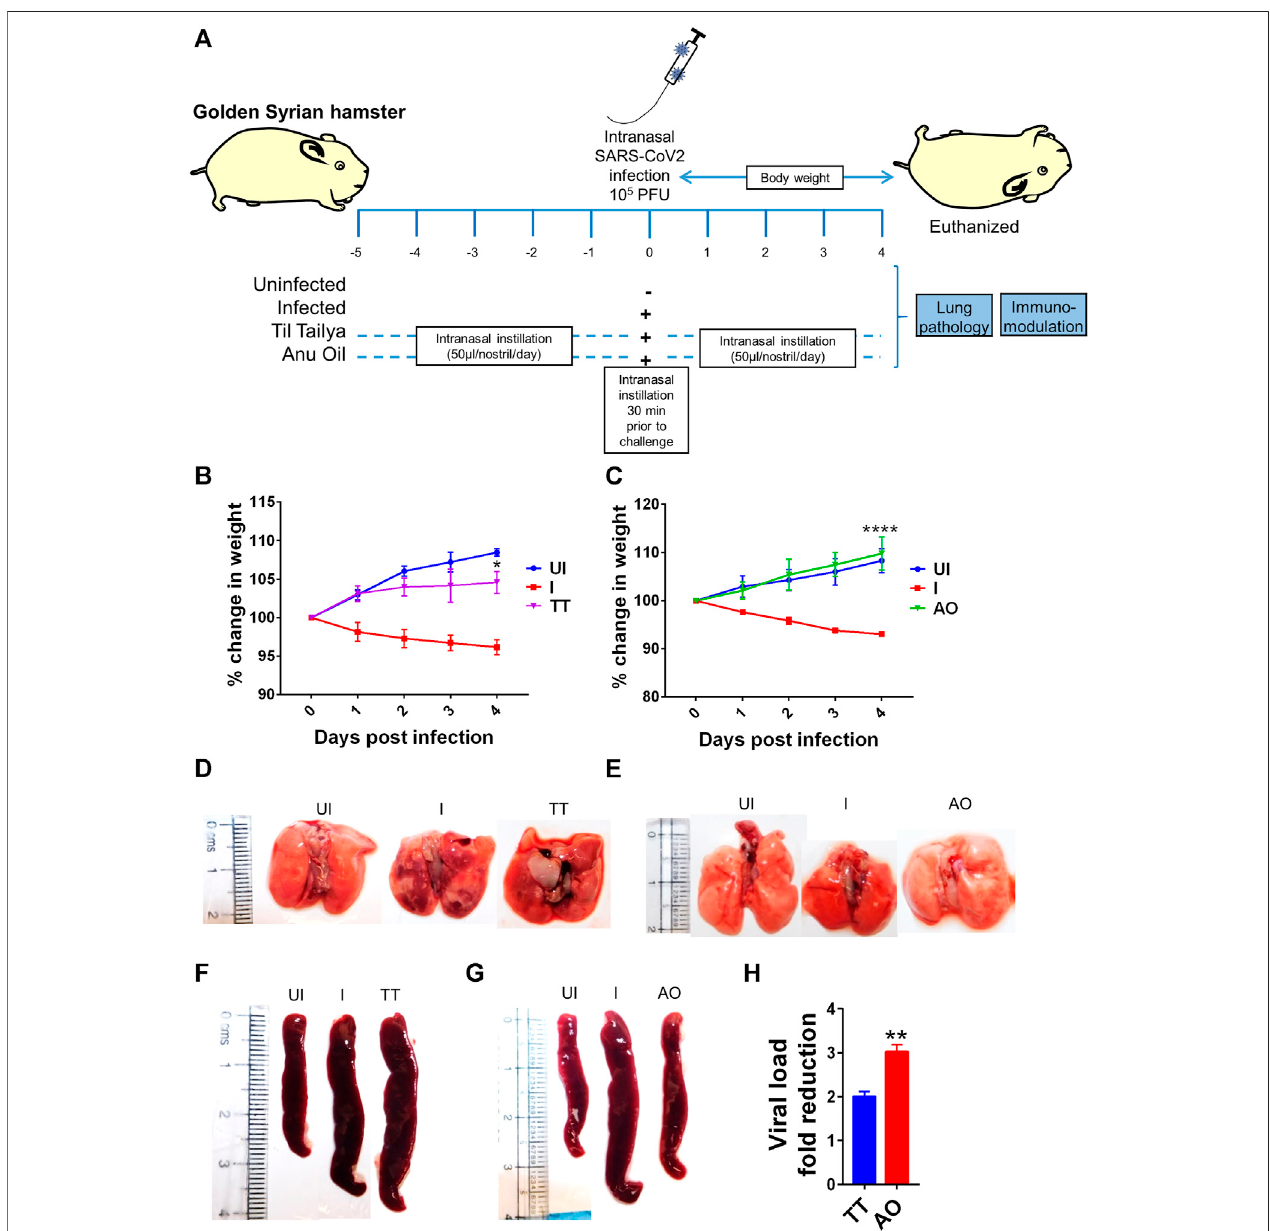
FIGURE 1 | Effect of intranasal instillation of Anu oil and til tailya on gross clinical parameters and lung viral load in SARS-CoV2 infected hamsters. (A) Schematic outlines thestudy design. Prophylactic treatment regime was adopted for Anu oil (AO) and til tailya (TT) with each animal receiving (50 µl/nostril/day) intranasal instillation of Anu oil, til tailya, or mock control 5 days before challenge and then continued till after infection till end point (i.e., 4 days postinfection). One group was challenge and received live infection (I); the other group of animals was unchallenged healthy control (UI). On the day of challenge, the animals were given intranasal oil-instillation 30 minpriortochallengewithSARS-CoV2. (BandC) Linegraphshowingmean%changeinbodyweightpost-infection ± standarderrormean(SEM). (DandE) Images oftheexcised lungsshowinggrossmorphologywithpneumonitisregion(darkredpatches). (FandG) Imagesofexcisedspleenindicatingchangesinthespleenlength. (H) Bar graph showing mean fold reduction in lung viral load ± SEM as compared to the infected (I) control. * p < 0.05, ** p < 0.01, **** p < 0.0001 ( t -test).